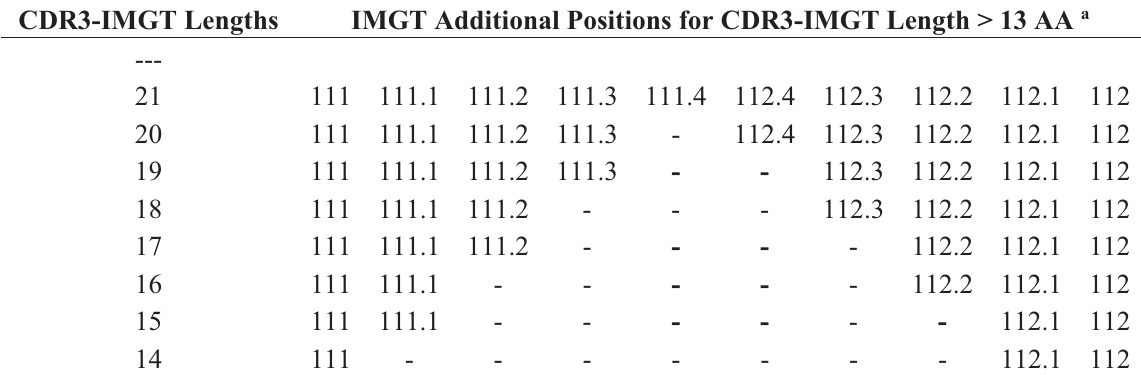
Table 3. IMGT additional positions for